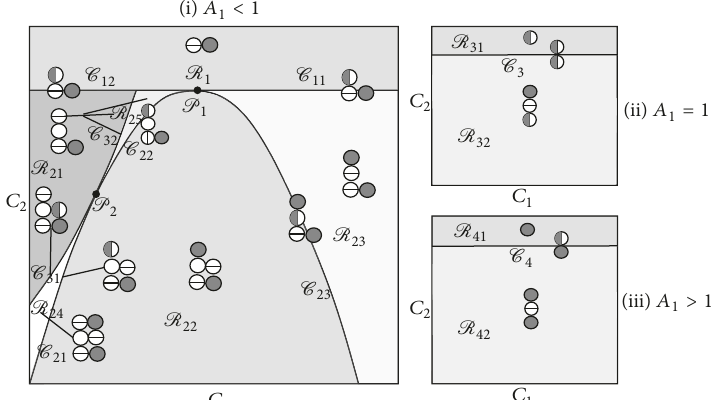
Figure 2: Equilibria in different parameter regions for the number of equilibria of system (1) when 𝐴 1 , 𝐴 2 , 𝐵 1 , and 𝐵 2 are fixed positive real numbers, as given by Proposition 11. Each circle in the parameters (𝐶 1 , 𝐶 2 ) -plane indicates the existence of an isolated equilibrium point of system (1) in the nonnegative quadrant of the 𝑥𝑦 -plane. Local stability character of equilibria as given in Theorem 19 is indicated as follows: ∙ , locallyasymptoticallystableequilibrium; ⊖ ,saddle; ⃝